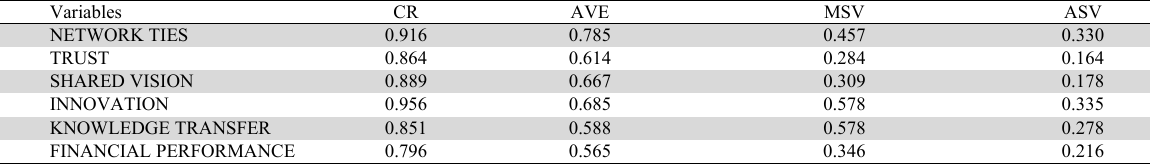
Reliability and Convergent Validity of Measured Variables